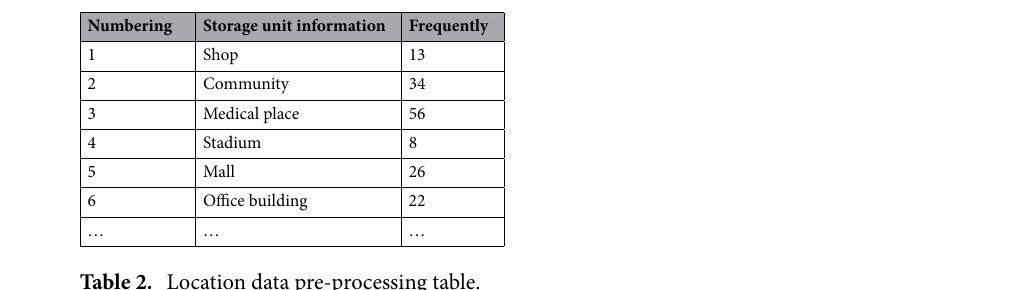
Table 2. Location data pre-processing